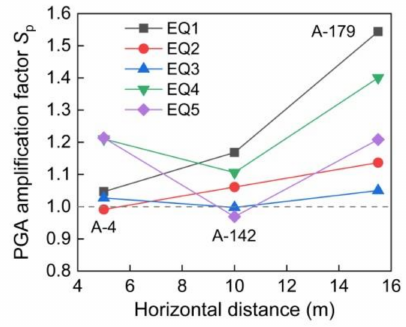
Figure 4. The horizontal acceleration amplification factor distribution from the inside of the slope to its surface at a height of 15.8 m in the 1# model in centrifuge